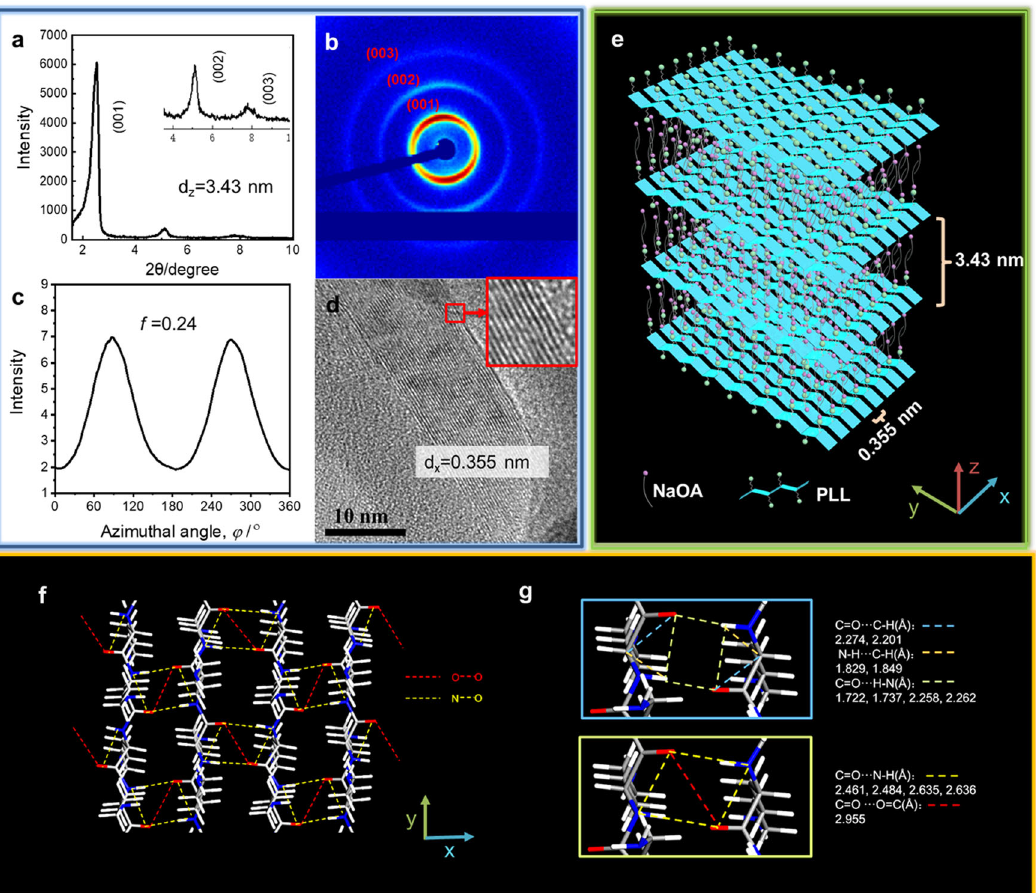
Fig. 2 The multilayer ordered structure of the PLL-OL fi lm. a XRD (X-ray diffraction) patterns, b 2D SAXS (2-dimensional small-angle X-ray scattering) image, c azimuthal angle ( φ ) plot, and d TEM image of the PLL-OL fi lms. e Schematic illustrations of PLL-OL self-assembled multilayer ordered structure. f Exampled through-space electronic communications among N ⋅⋅⋅ O and O ⋅⋅⋅ O units in PLL-OL fi lm. g Exampled intermolecular interaction between PLL